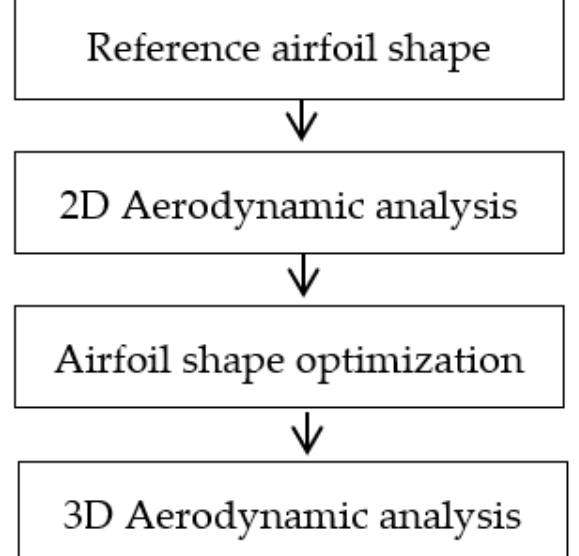
Figure 11. The adaptive airfoil shape optimization methodology.